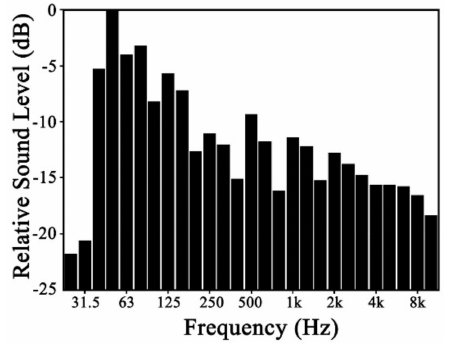
Figure 2. Spectral characteristic of point